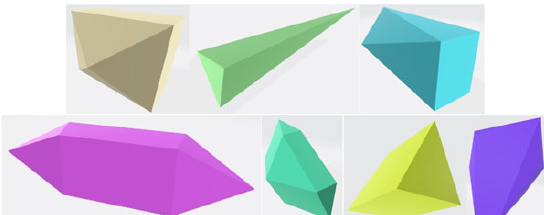
Fig. 9. Convex Pieces (1 to 7 from left to right) of the data set SGSPM05 from Stoyan et al.